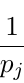
Figure 1 . (Half of) different monodromy conditions or field identifications related to the four twist operators σ , σ , σ and σ in the case m = 4 , n = 2 . The twist operator σ g A g B g − 1 g − 1 A B equivalently represented in another useful notation σ for this particular picture, where (1278)(3456) (1278) denotes the cyclic permutation of these four numbers. Here to keep the picture tidy and clean, we only show half of the identifications (1278)